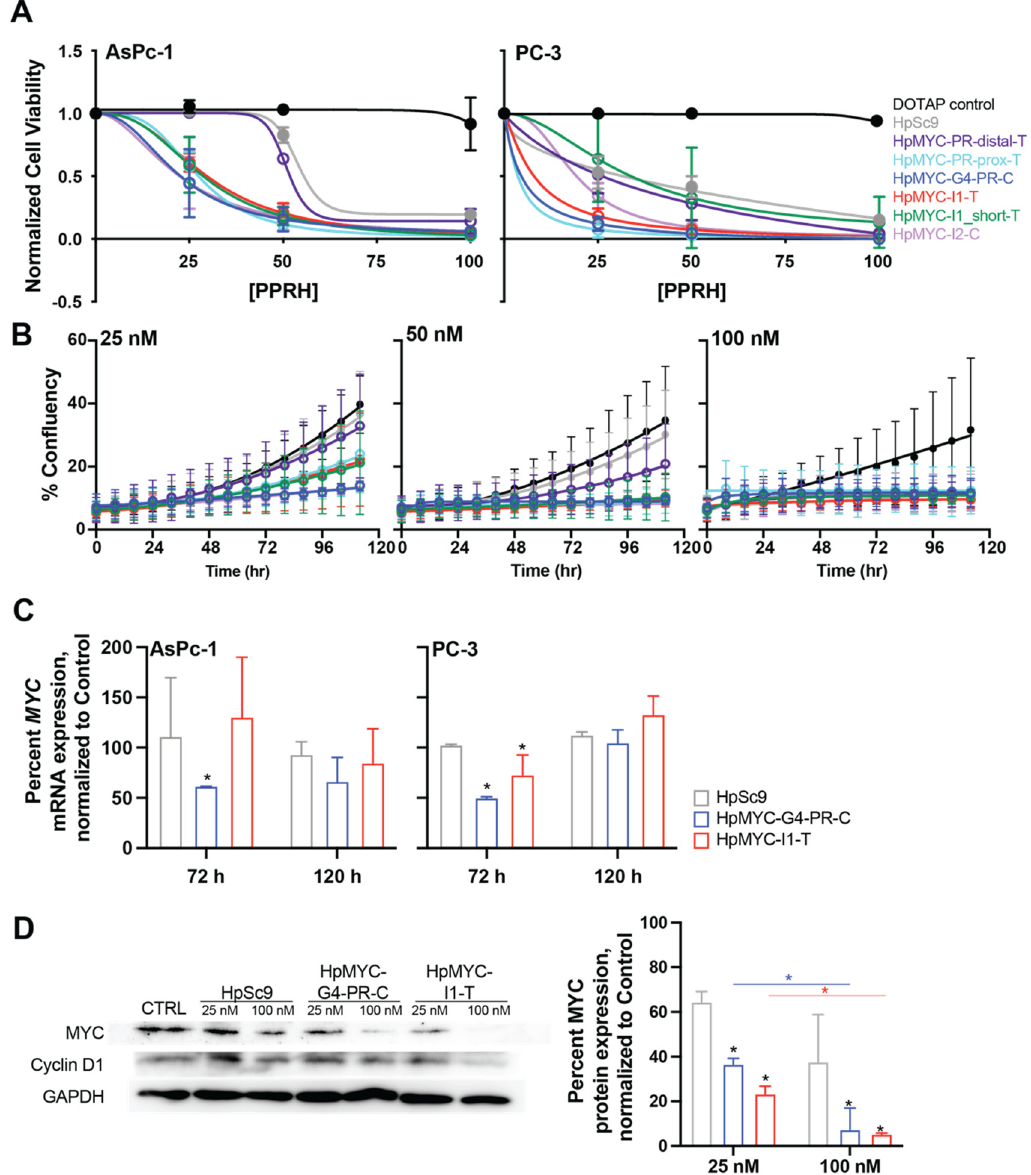
Figure 7. Effect of MYC targeting PPRHs in cell viability, growth confluence, mRNA, and protein levels in prostate (PC-3) and pancreatic (AsPc-1) cancer cell lines. ( A ) Dose-dependent effects of PPRHs on the viability of PC-3 prostate cancer and AsPc-1 pancreatic cancer cell lines were measured after 120 h. ( B ) The same PPRHs were monitored over time in AsPc-1 pancreatic cancer cells at 25, 50, and 100 nM for their effects on cell growth, as measured by confluency. Notably, changes in confluency became evident 72 h post-incubation, driving the selection for times to monitor changes in transcription ( C ) and translation ( D ). ( C ) Changes in MYC mRNA, as normalized to GAPDH and again to DOTAP-treated vehicle controls (not shown), were examined in both cell lines at 72 and 120 h post-treatment. Experiments were repeated at least 3 times, with duplicate technical replicates in qPCR experiments. * p < 0.05 as compared to vehicle-treated controls as determined by one-way ANOVA with post hoc Dunnett analyses. ( D ) PPRH (HpSc9, HpMYC-G4-PR-C, and HpMYC-I1-T) changes in translation were examined in PC-3 cells, as the more sensitive cell line, in a dose-dependent manner 72 h post-treatment. Representative images of MYC and Cyclin D1 pro- teins, and GAPDH loading control are shown (left) and semi-quantitation reveals a dose-dependent decrease in MYC expression. Experiments were repeated in duplicate; * p < 0.05 as compared to